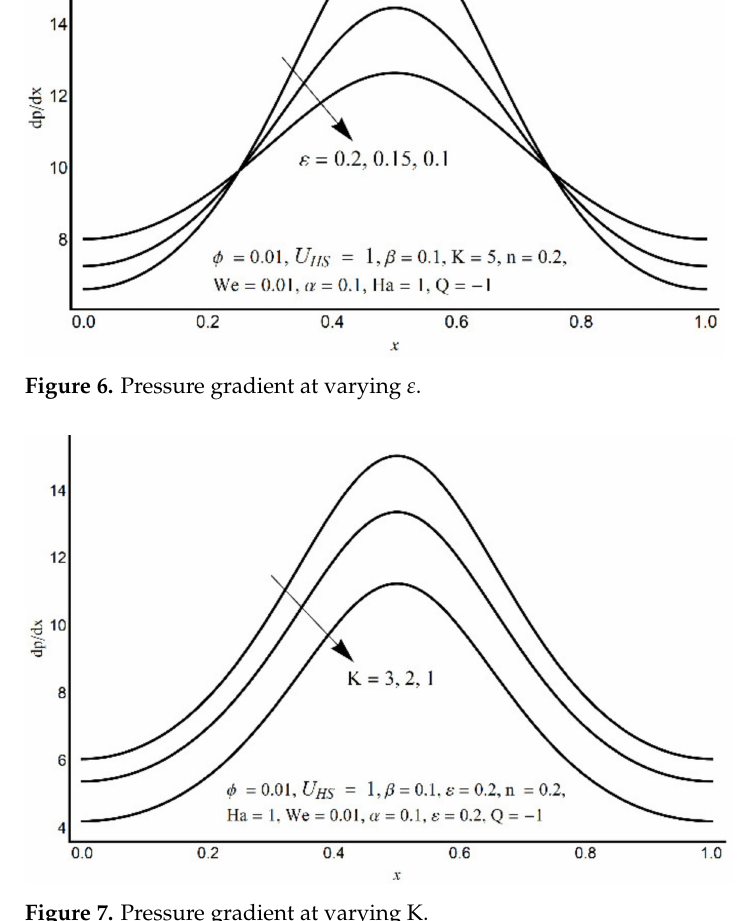
Figure 7. Pressure gradient at varying K.